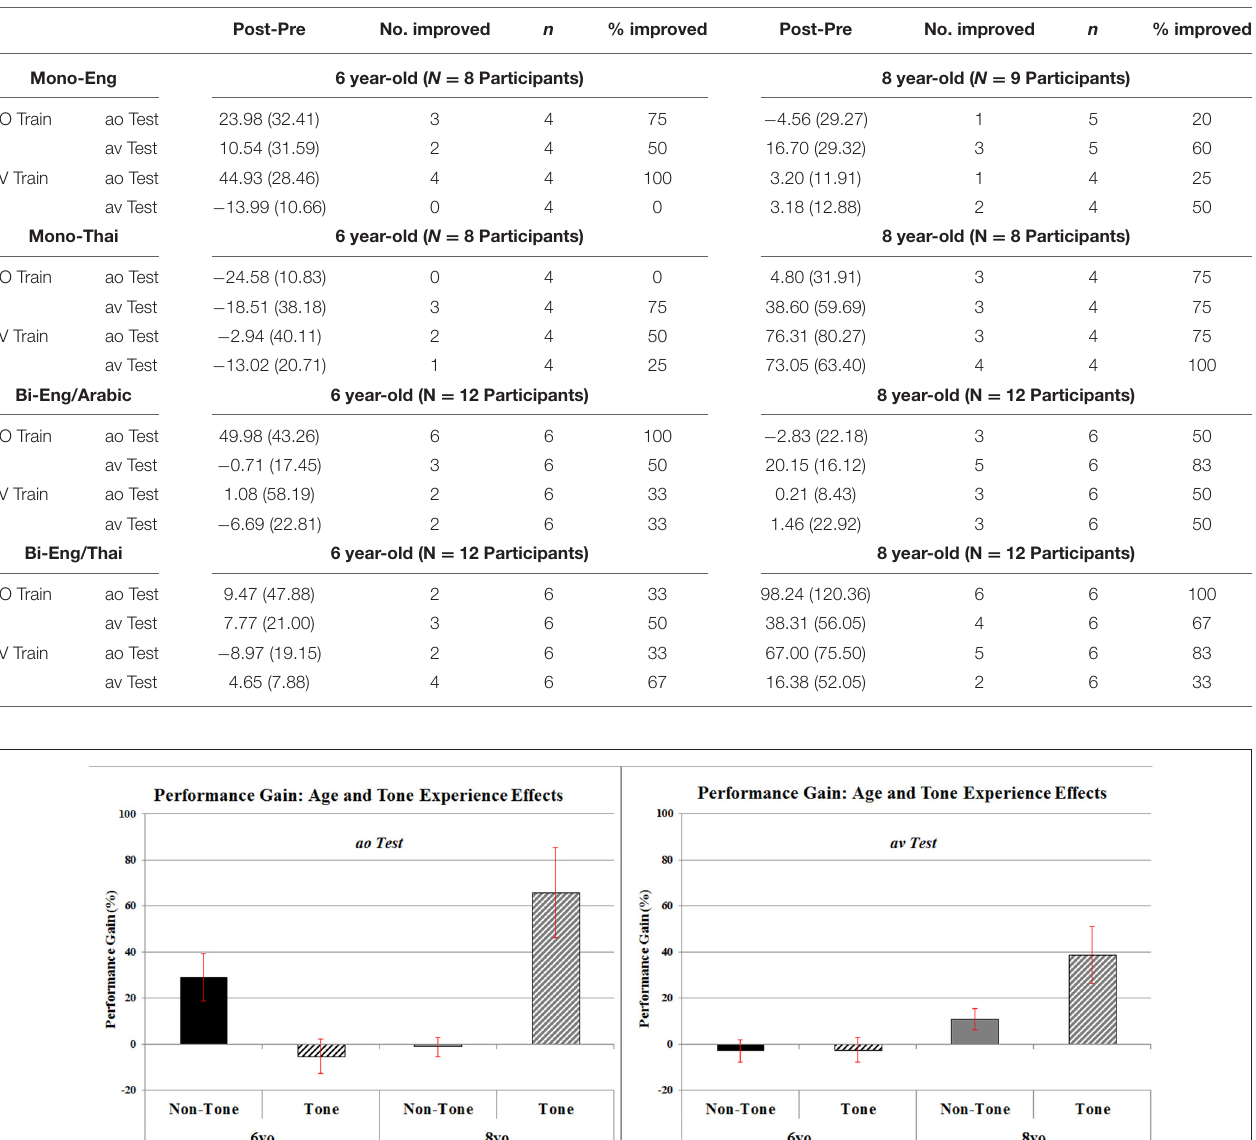
TABLE 1 | Mean (and SD ) Performance Gain and number and percent of participants who improved in each group. Post-Pre No. improved Post-Pre